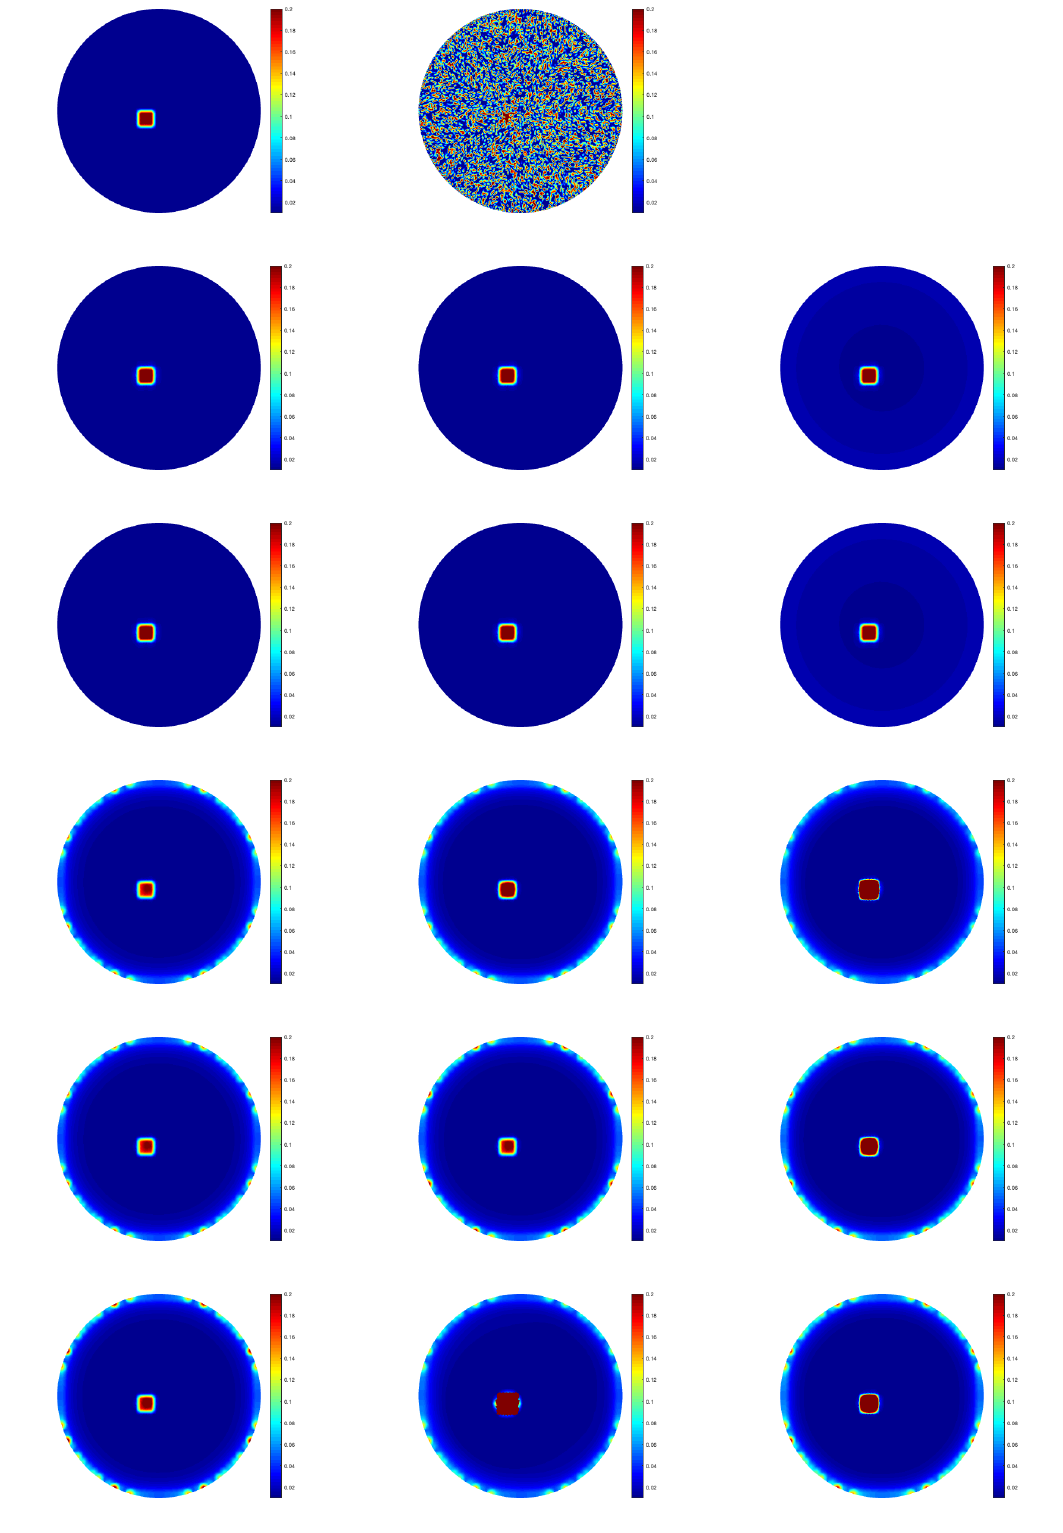
Figure 10. Reconstruction of the absorption coefficient µ a with one inclusion. The first row presents the true image ( left ) and initial guess image with an initial guess error δ = 0.2 ( right ). The second, third, fourth, and fifth rows present the reconstruction images using the learning rate β taking values equal to 0.001,0.01,0.1, 0.2, and 0.3, respectively, using Nadam, Adam, and AmsGrad, from ( left to right